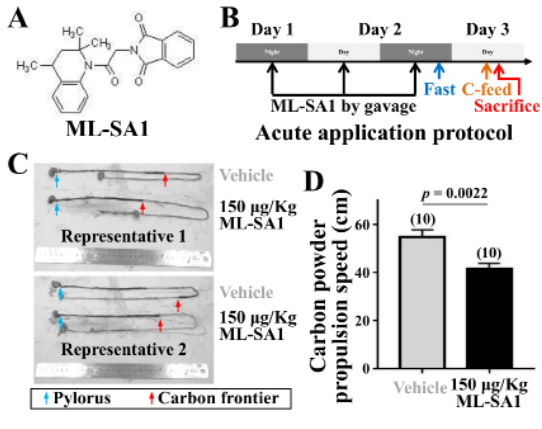
Figure 1. ML-SA1 treatment slowed Intestinal propulsion rate in mice. (A) The chemical structure of ML-SA1. (B) The detailed protocol of applying ML-SA1 (150 μg/kg, dissolved in DMSO as 10 mM stock) to mice. (C) Representatives of the intestinal propulsion rate test. Blue arrow, the beginning of length measurement; Red arrow, the end of length measurement. (D) Summary of (C). Numbers in the brackets indicated the number of mice used. Data were presented as mean ±